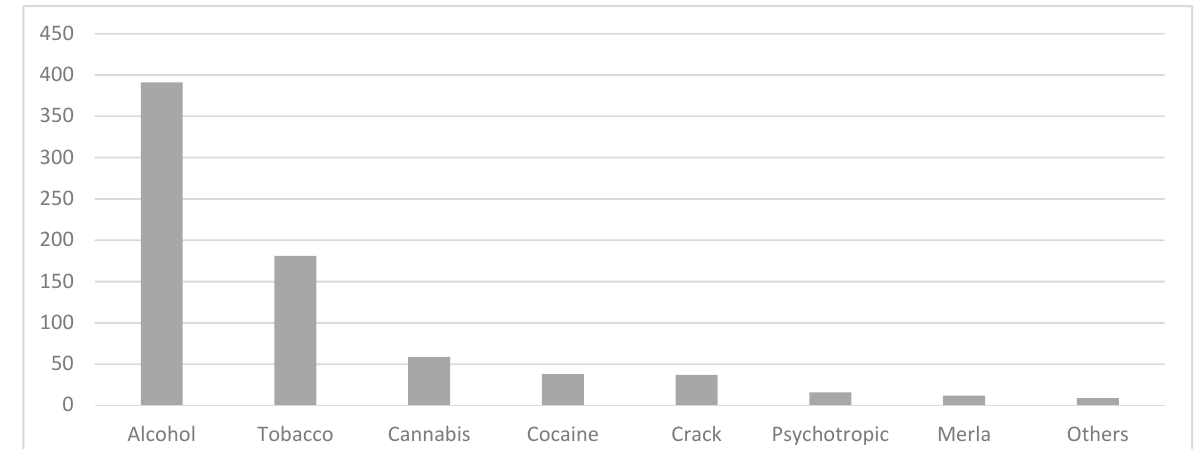
Figure 1. Legal and illegal drugs consumed by elderly assisted by CAPS-AD from DF between 2000 and 2017. The number of users exceeded the total amount of the sample due to the use of drugs in association.